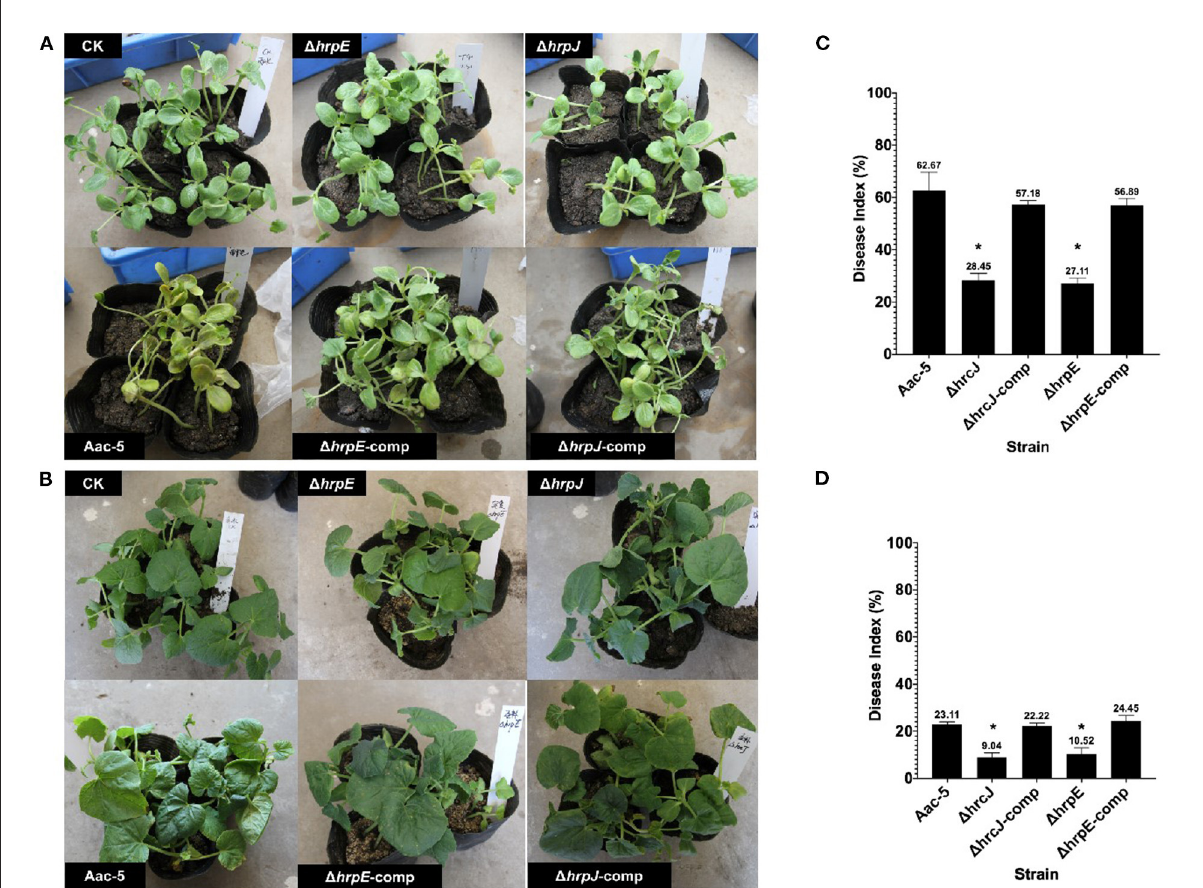
FIGURE4 Virulence of A. citrulli strains on watermelon (A) and melon (B) seedlings 8 days after spray inoculation. Aac-5, wild-type strain; 1 hrcJ , hrcJ mutant strain; 1 hrcJ -comp, 1 hrcJ complementation strain; 1 hrpE , hrpE mutant strain; 1 hrpE -comp, 1 hrpE complementation strain. (C,D) Statistical analysis of the virulence of Aac-5 strains. Disease index for each A. citrulli strain was calculated from three experiments based on a 0 to 9 disease severity reading of each seedling in each experiment. Disease index with * indicates a significant difference as compared to that of the wild-type strain ( P <